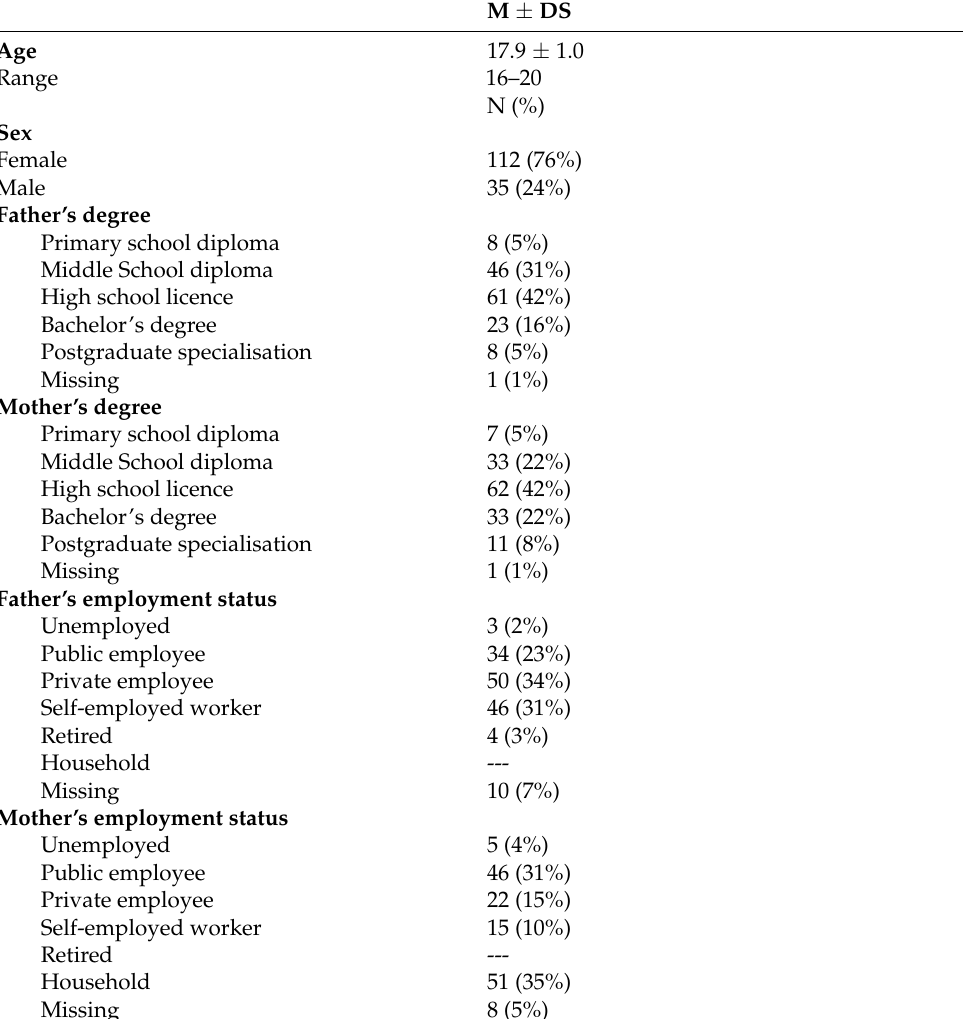
Table 1. Demographic characteristics of the sample (N =